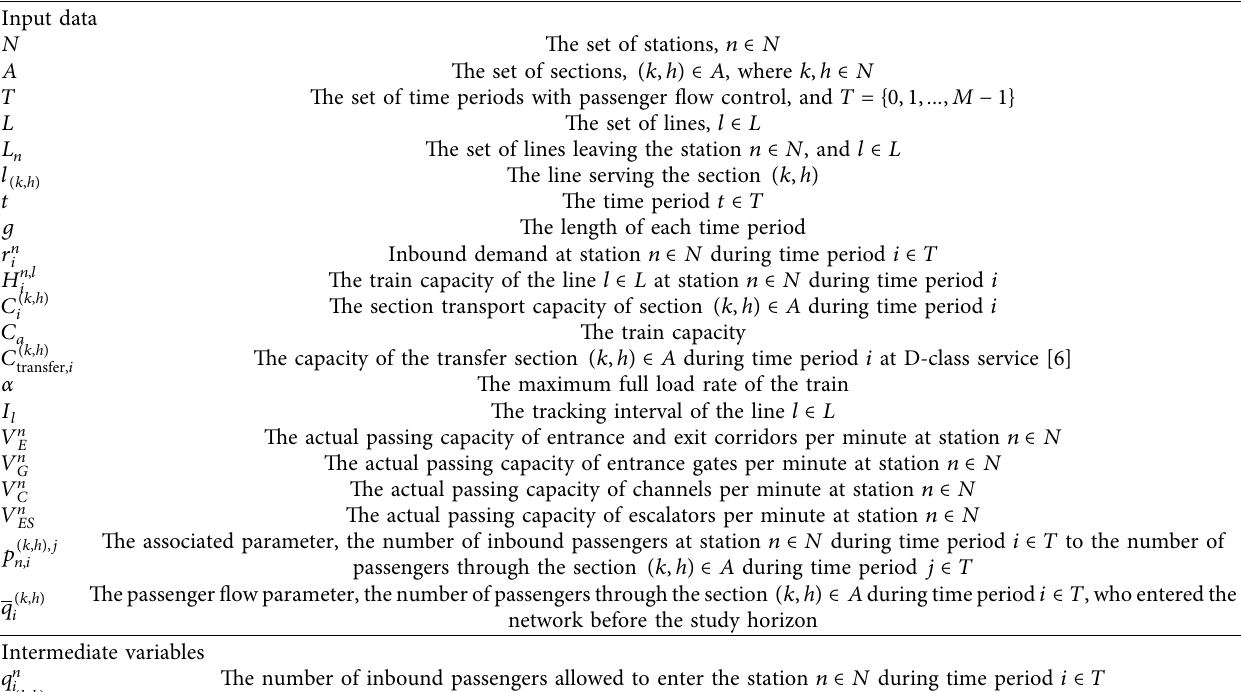
Table 1: Input data and variables.